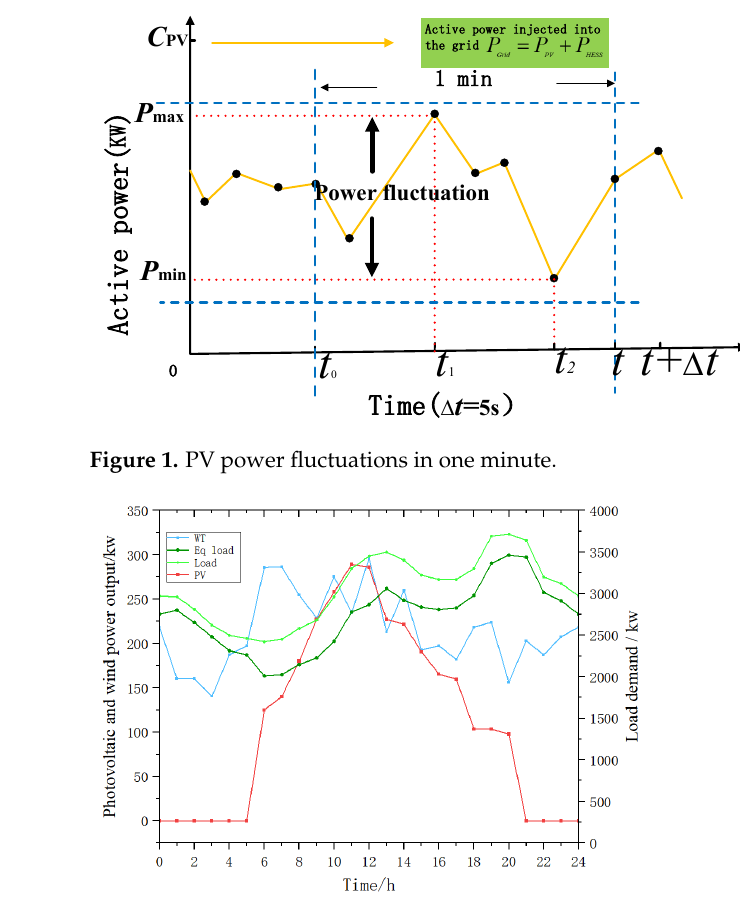
Figure 2. Comparison of the load curve and the volatile energy output.